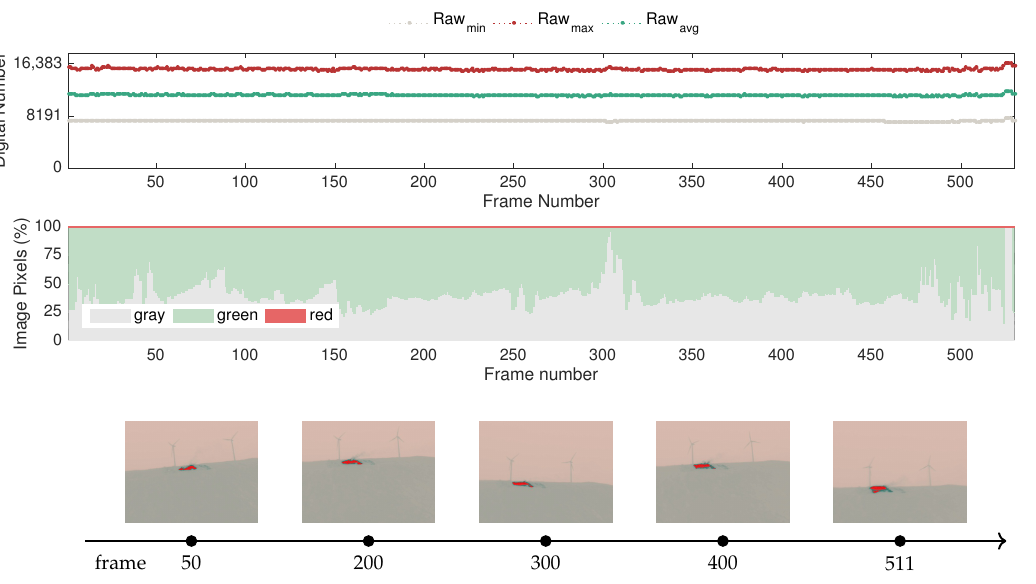
Figure 21. Results for fire detection at long distance in a mountain range: raw features ( top ); color features ( center ); sample frames ( bottom